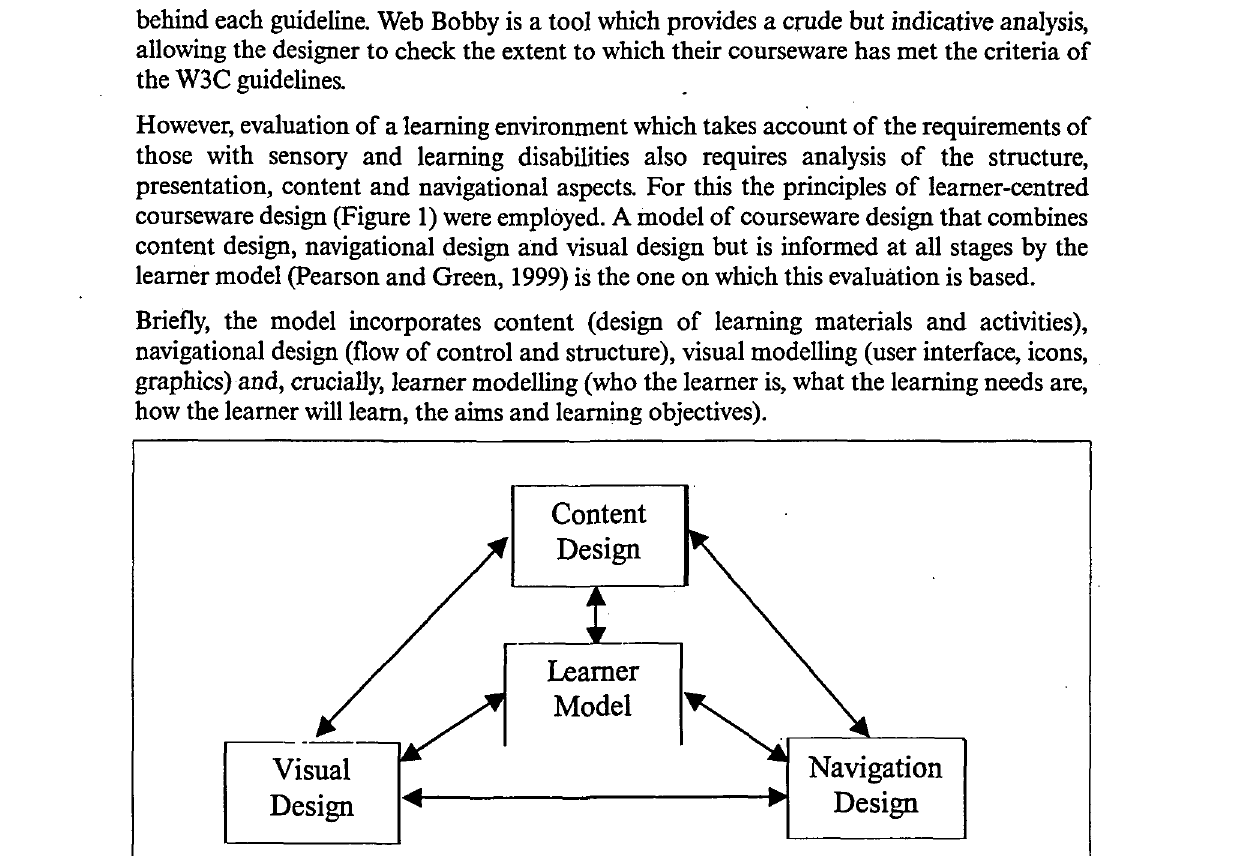
Figure I: A model ofleamer<entred courseware design (adapted from Pearson and Green,